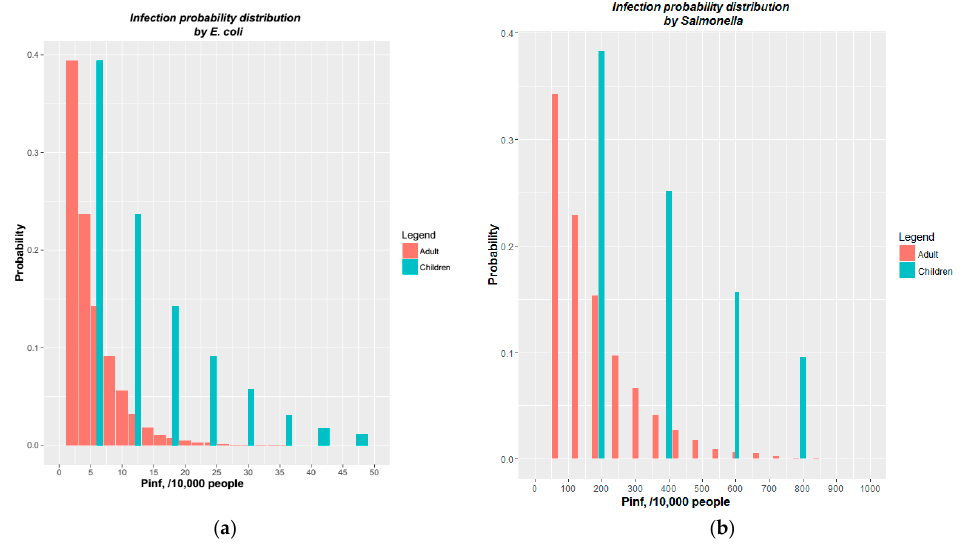
Figure 2. Infection probability distribution of ( a ) E. coli and ( b ) Salmonella. Table 4. Summary of infection probability of Salmonella , E. coli , Rotavirus , Campylobacter and Cryptosporidium (over 10,000 people in contact with the floodwater).